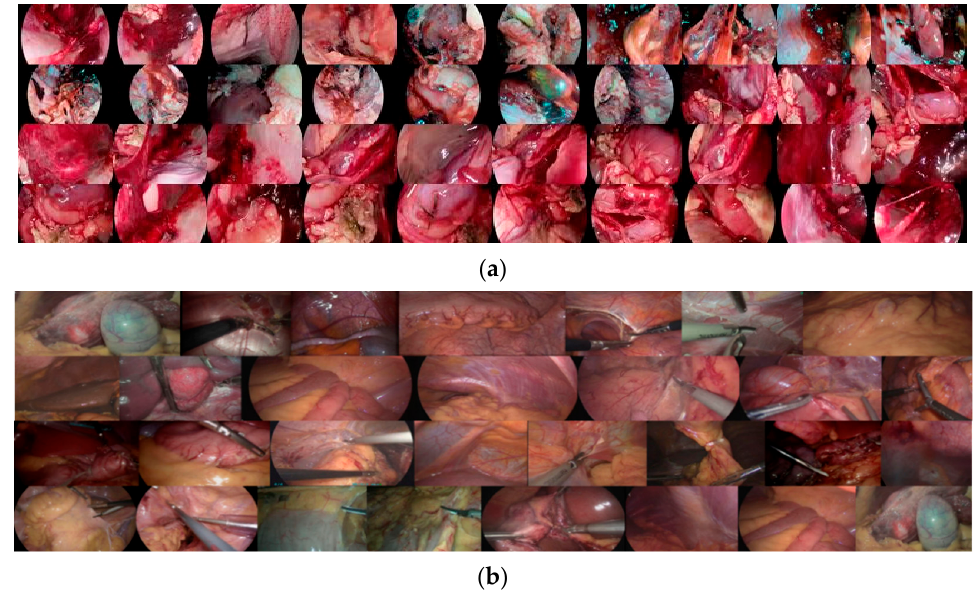
Figure 7. The images of the training and test sets. ( a ) shows part of the training set images; ( b ) shows the test set images. the test set